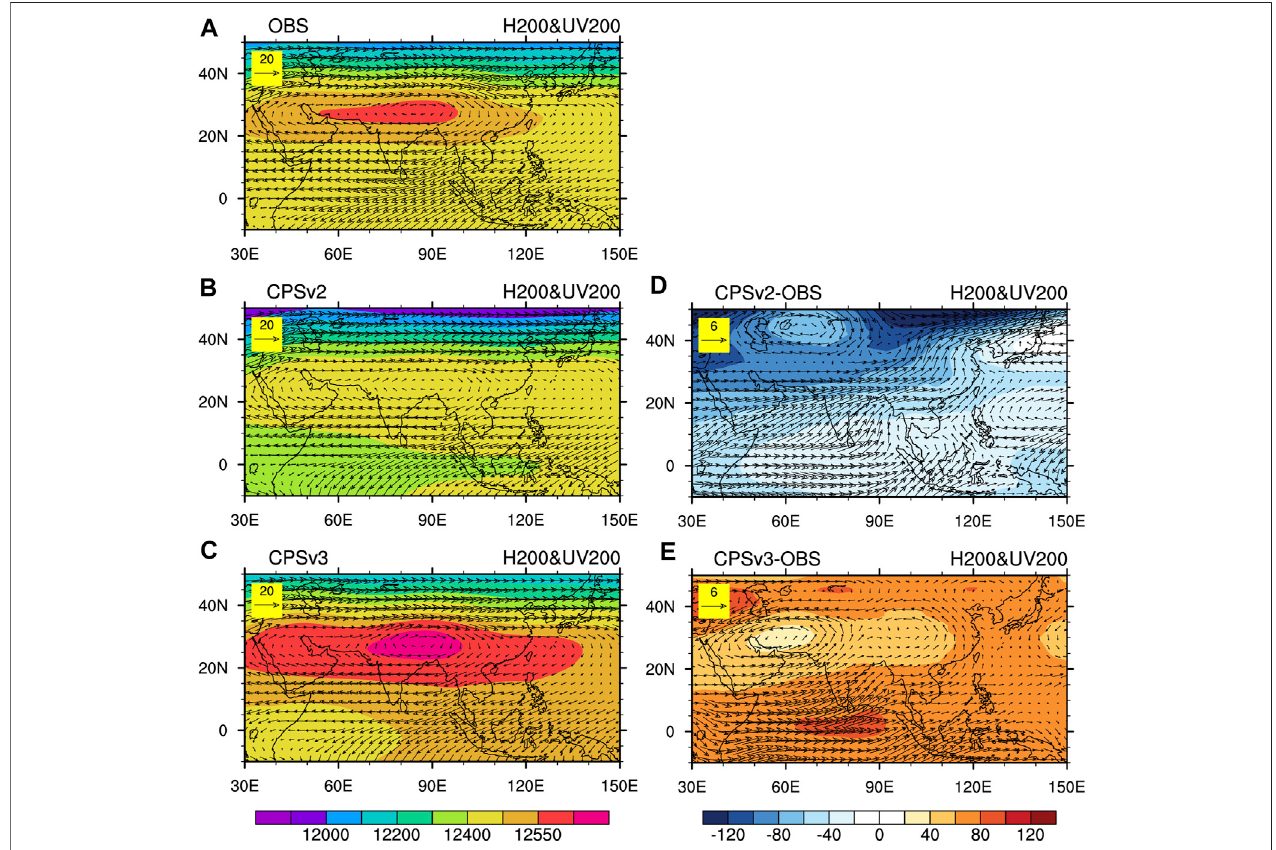
FIGURE 2 | Climatology of the JJA geopotential height (gpm, shading) and winds (m s − 1 , vectors) at 200 hPa from (A) observation, (B) CPSv2, and (C) CPSv3 hindcasts. Also, climatological biases of (D) CPSv2 and (E) CPSv3 hindcasts.